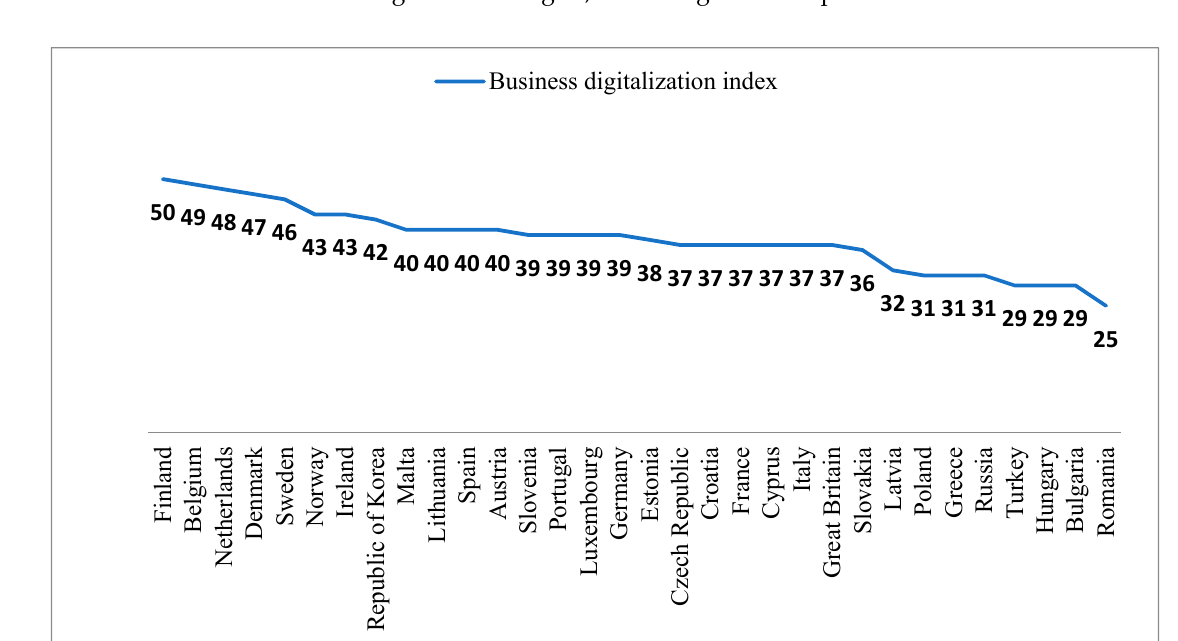
Figure 1. Rating of countries by the business digitalization index in 2018. Source: Compiled based on (Abdrakhmanova et al. 2020).